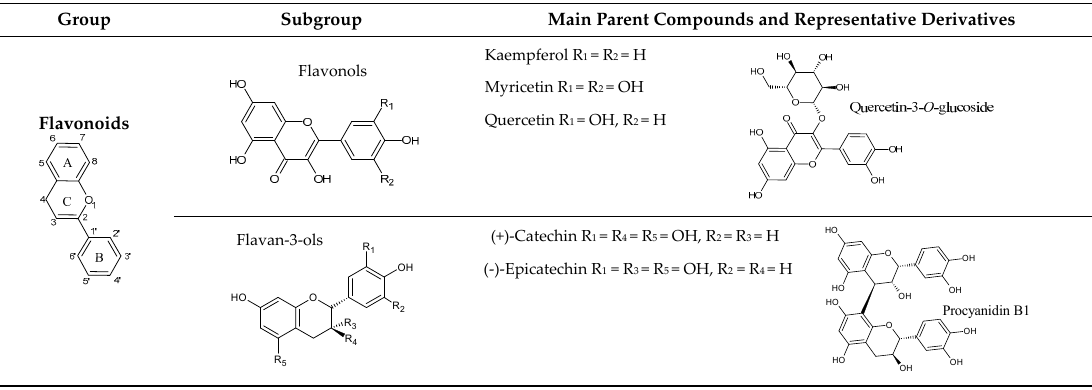
Table 1. Classification of phenolic compounds found in wine.